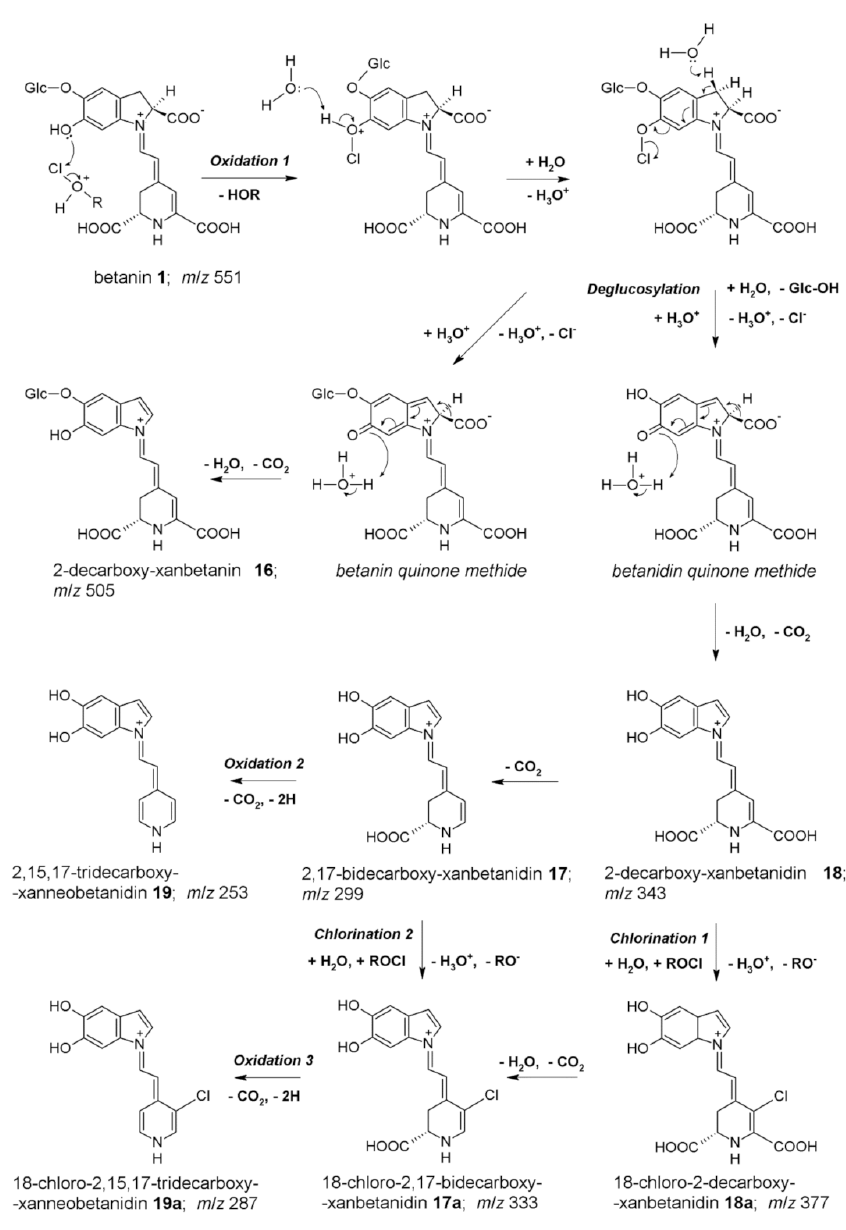
Figure 5. Proposed mechanism of betanin oxidation by NaOCl with subsequent alternate pathways of deglucosylation, decarboxylation, and chlorination steps based on this contribution and previous study